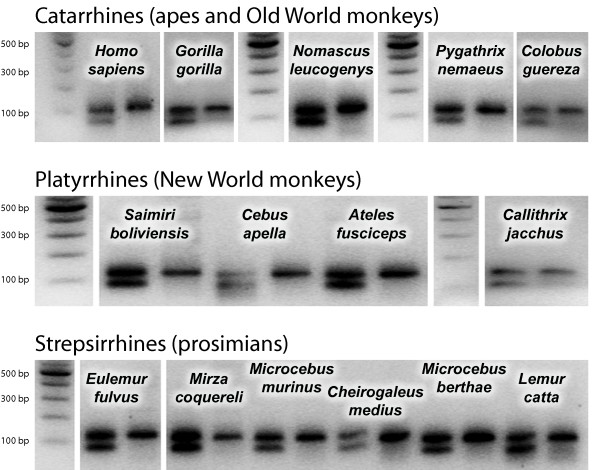
Successful sexing in XX primate species. The primers were successfully tested in apes, New World monkeys, Old World monkeys and prosimians using identical PCR conditions. Males: two bands (XY), females: one band (XX).